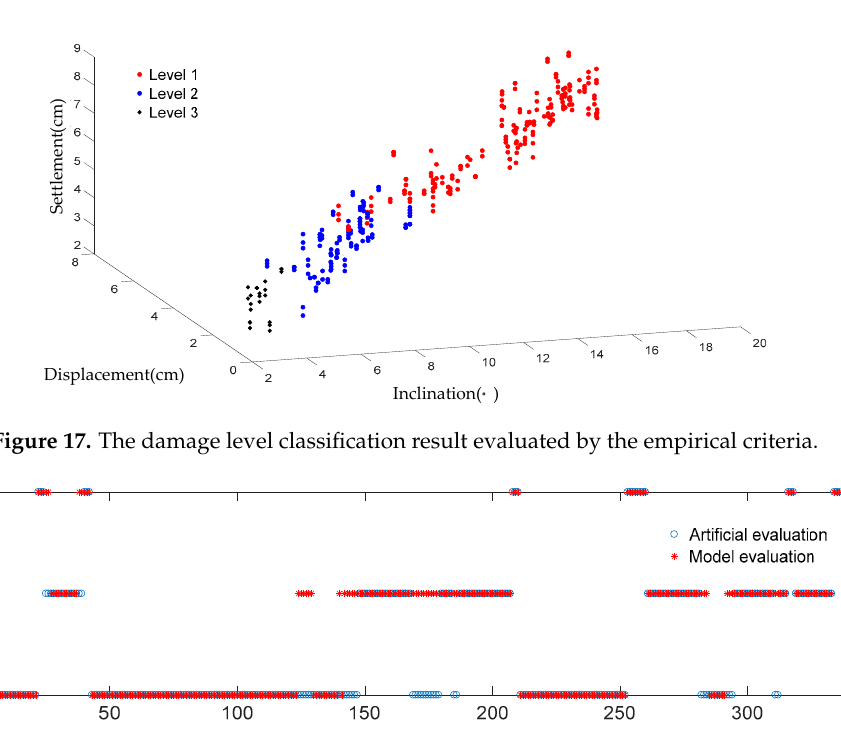
Figure 18. A comparison between the damage level classification result evaluated by the empirical approach and that predicted by the KNN-SVM model.